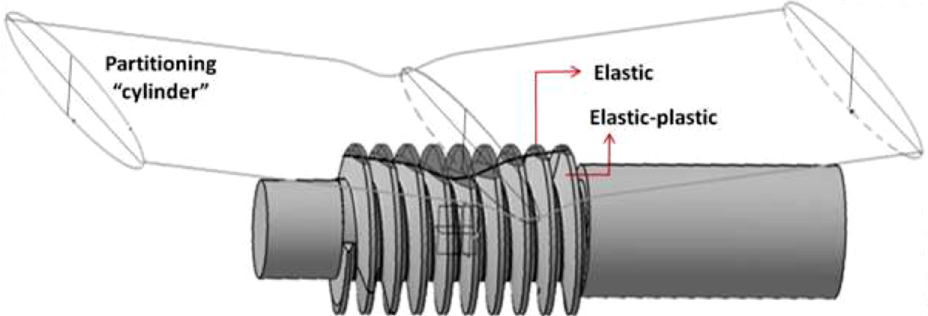
Fig. 5. Geometry partitioning of the worm using a “ generalized ” cylinder with elliptical section and curved axis. After partitioning, the upper part of the worm is elastic, and the lower part is elastic –